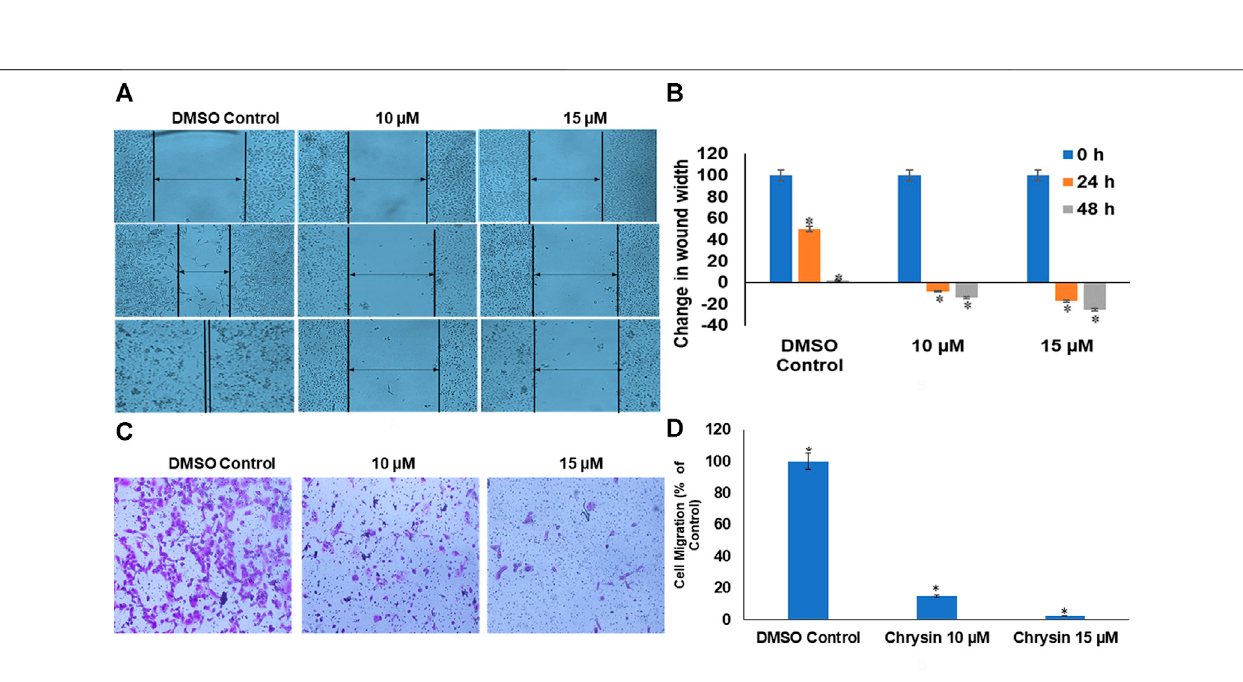
Table 2 ). Fold changes in protein expression were calculated by comparing the treated cells with those of the DMSO control. The upregulation was fi xed at ≥ 1.5 fold and downregulation at ≤ 0.5 fold.